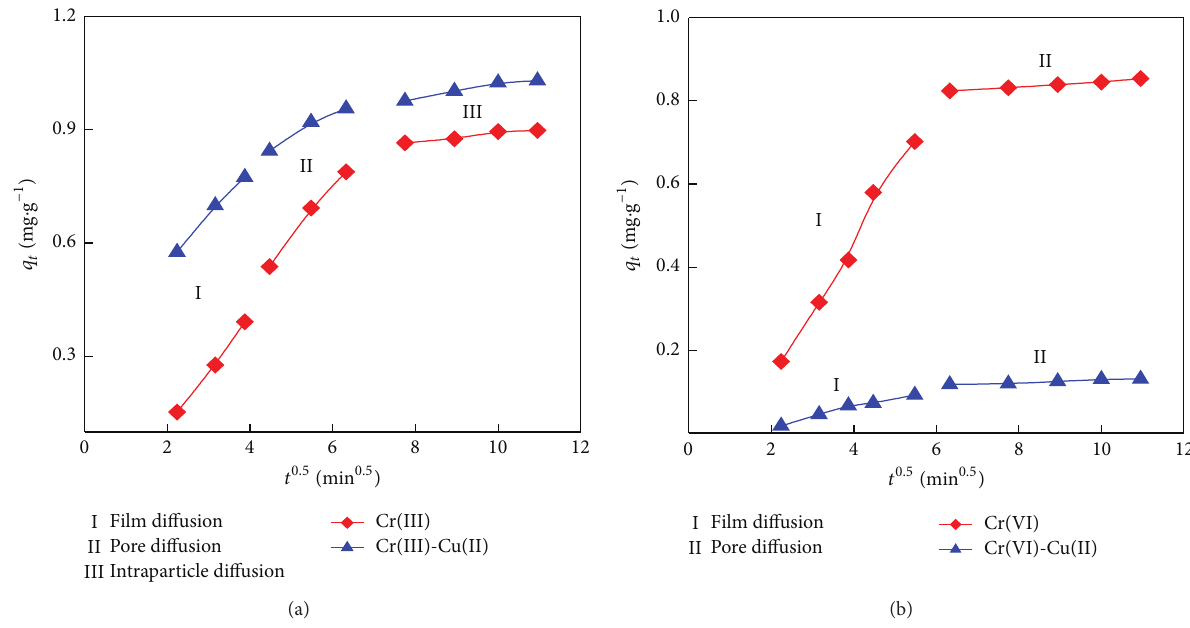
Figure 2: Intraparticle diffusion plots for Cr(III) (a) or Cr(VI) (b) adsorption onto kaolin in the absence and presence of Cu(II) (adsorption conditions: initial concentration for Cr(III) = 300 mg ⋅ L −1 , for Cr(VI) and Cu(II) = 200 mg ⋅ L −1 , temperature = 25 ∘ C, pH = 4.5, and equilibrium time = 120